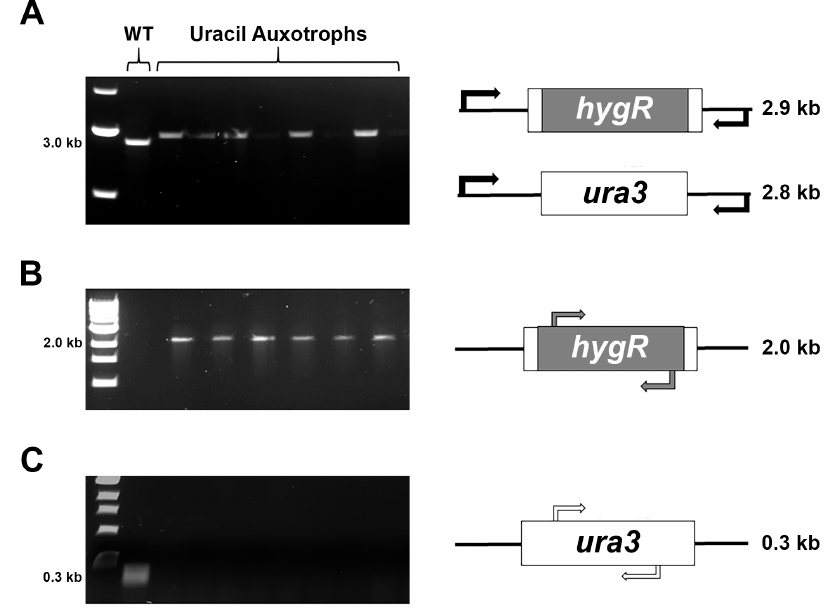
Figure 3. Genotyping of uracil auxotrophs. ( A ) Amplification of the ura3 locus using primers 3 and 4 yields the expected 100 bp band shift between the wild-type and the uracil auxotrophs. ( B ) Amplification of the hygR cassette from the amplicon in Figure 3A using primers 7 and 8. The uracil auxotrophs contain the hygromycin resistance cassette while the wild-type strain does not. ( C ) Amplification of the ura3 coding region from genomic DNA using primers 5 and 6. Only the wild-type contains the coding sequence for ura3 .